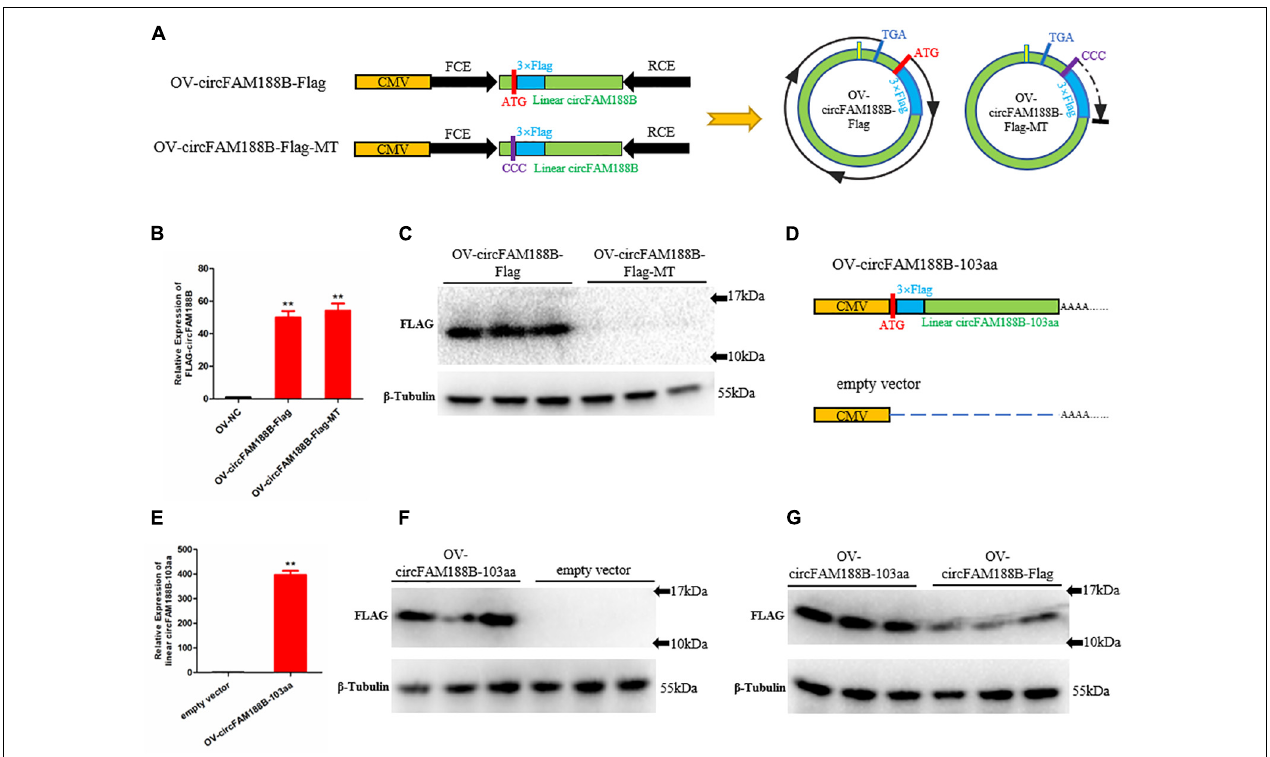
FIGURE 5 | CircFAM188B encodes novel protein circFAM188B-103aa. (A) Flag-tagged linear circFAM188B sequence and mutation type sequence (ATG mutation to CCC) were cloned into the pCD2.1-ciR vector (left) . Schematic diagram of the ORF of Flag-tagged circular RNA circFAM188B generated from the two linearized vectors shown on the left (right). (B) Relative expression of Flag-tagged circFAM188B in SMSCs transfected with Flag-tag vectors. (C) Flag-tagged protein levels in SMSCs transfected with Flag-tag vectors. (D) The linear Flag-tagged circFAM188B-103aa sequence was cloned into the pCDNA3.1 vector; empty vector was used as a negative control. (E) The relative RNA level of linear Flag-tagged circFAM188B-103aa in SMSCs transfected with these Flag-tagged vectors. (F) The Flag-tagged protein level of SMSCs transfected with these Flag-tagged vectors. (G) Flag-tagged protein levels in SMSCs transfected with OV-circFAM188B-Flag and OV-circFAM188B-103aa vector. The results of all groups are shown as mean ± S.E.M., and the data represent three independent assessment methods. Student’s t -test was used to compare expression levels or values among different groups. * P < 0.05; ** P < 0.01.